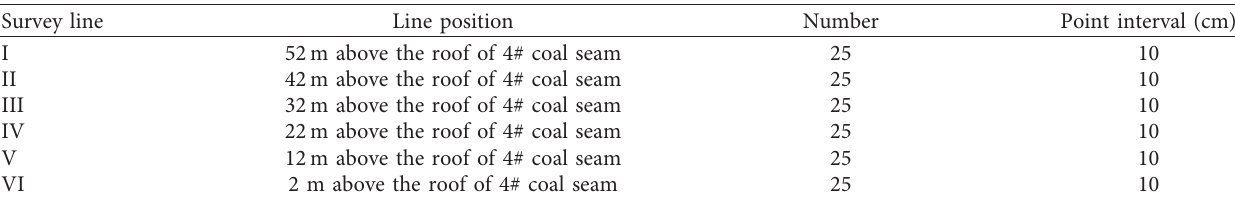
Table 2: Parameters of model monitoring